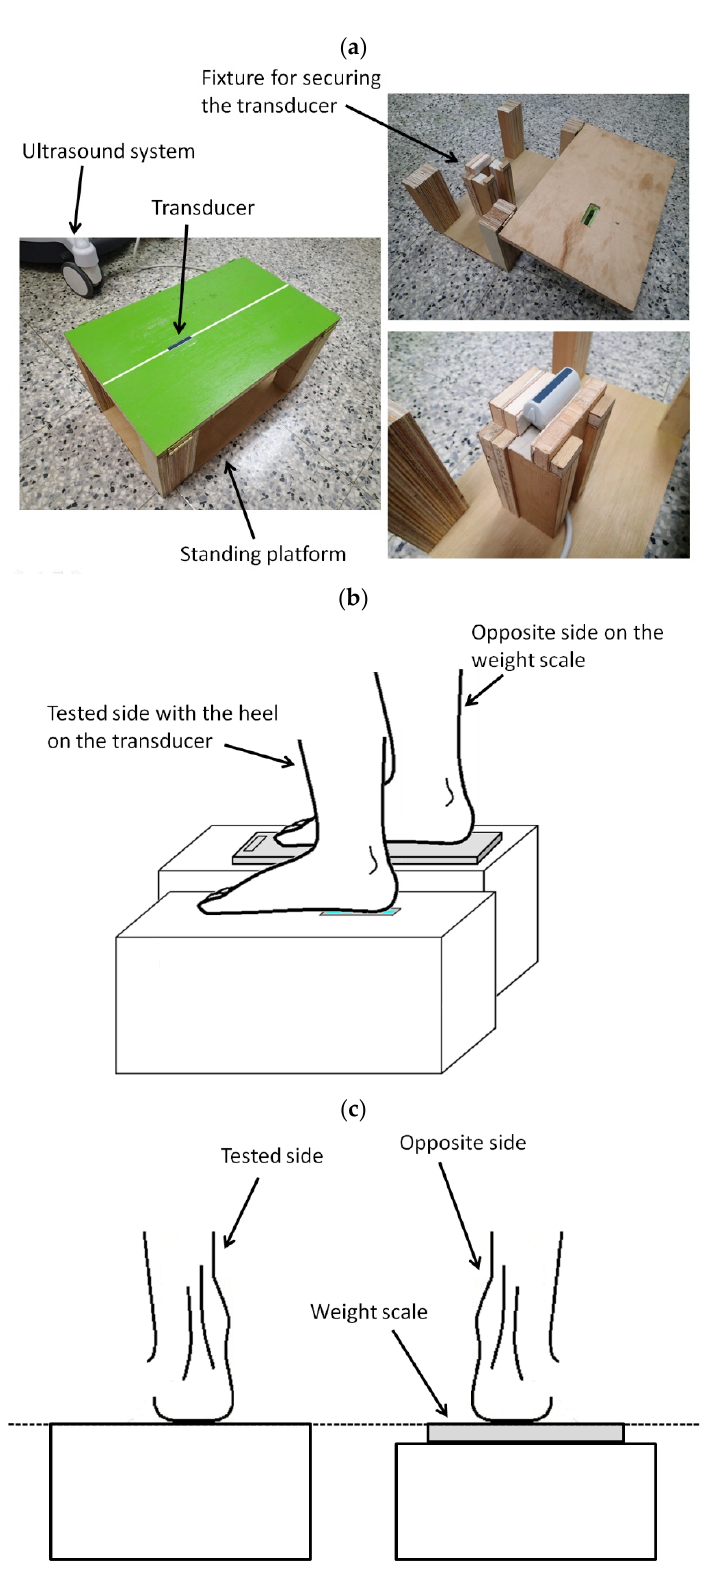
Figure 3. ( a ) The experimental setup for measuring the shear wave speed and thickness of MIC and MAC of the heel pad using SWE during static standing. ( b ) The foot was positioned so that the tested heel was right on the transducer. The other foot was on a weight scale on the other parallel platform. ( c ) The dimensions of both platforms were carefully designed so that there was no height difference between both